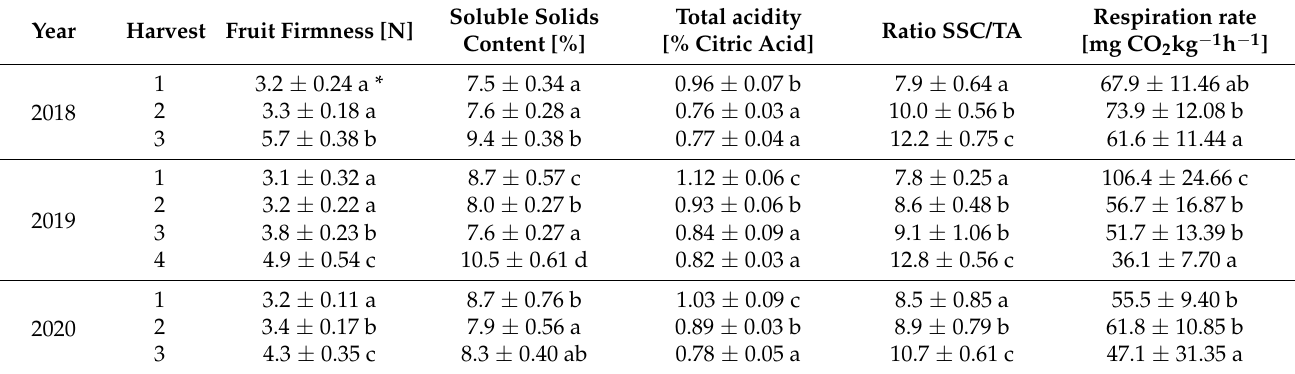
Table 1. Fruit quality of ‘San Andreas’ strawberry directly after